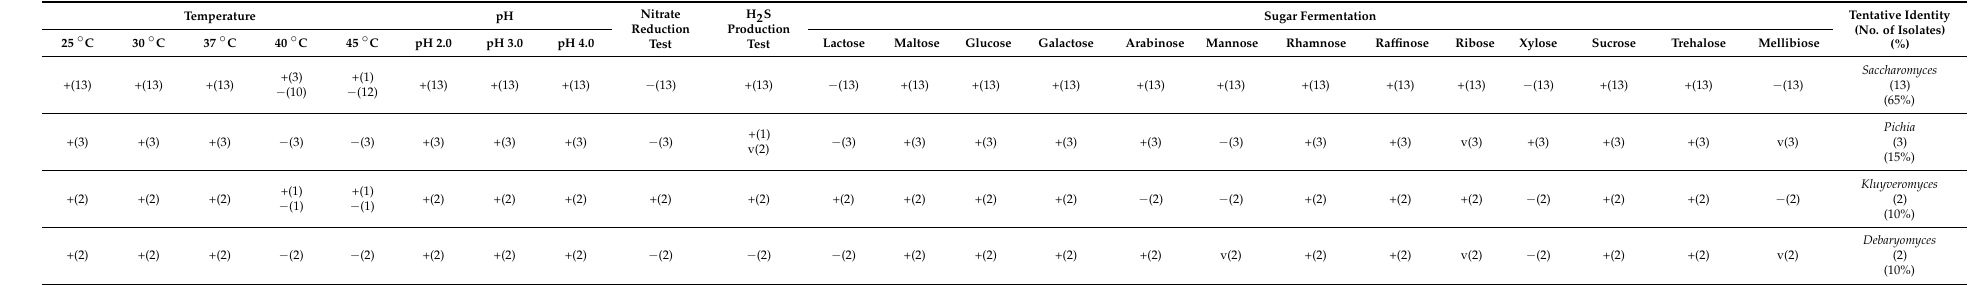
Table 3. Phenotypic characterization of probiotics yeasts isolated from dahi and chhurpi of